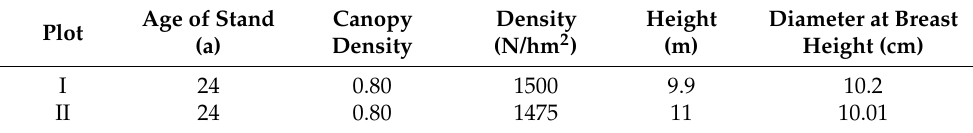
Table 1. Basic information of study plot.